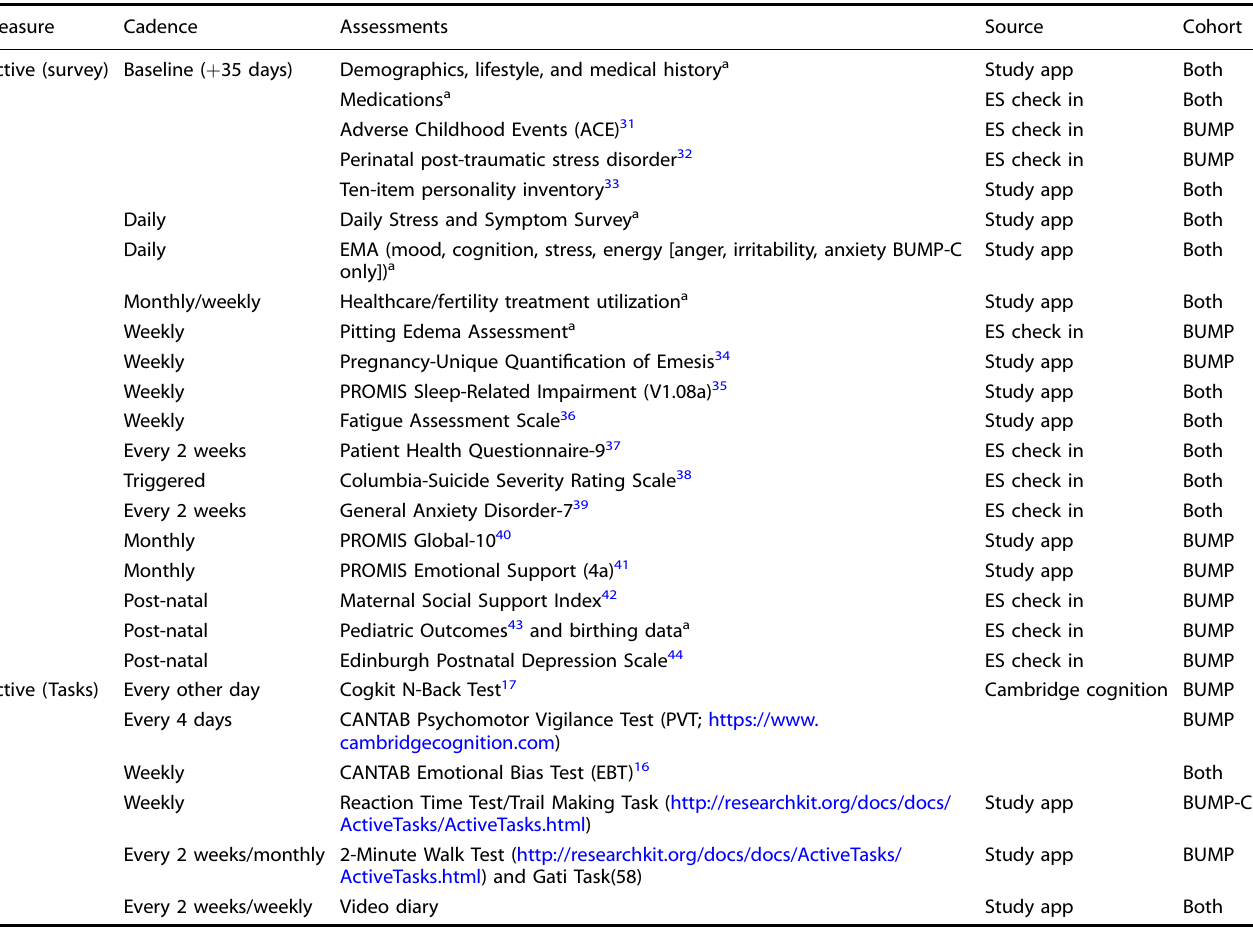
Table 1. Active study app surveys and tasks.